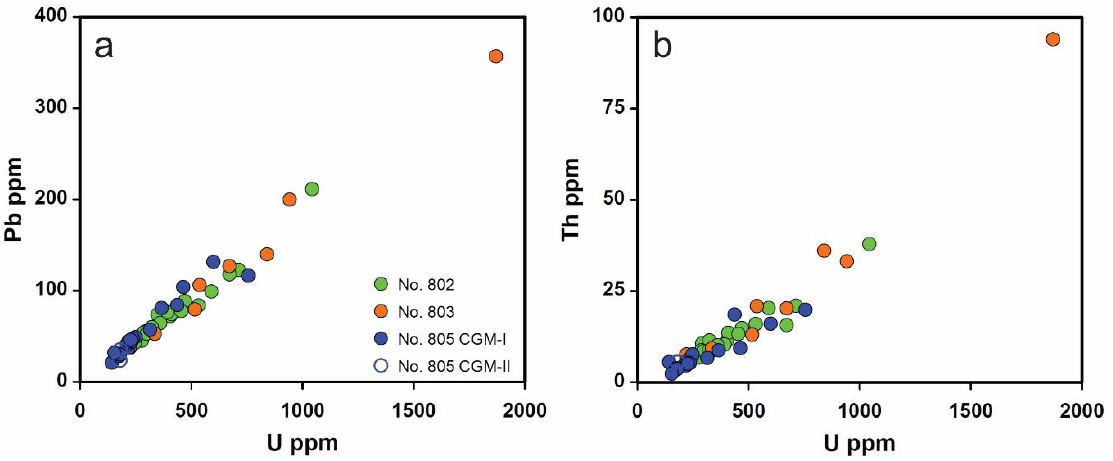
Figure 9. Binary plots for CGMs from the Li-rich pegmatites at Kalu’an. ( a ) Pb versus U plot and ( b ) Th versus U plot.